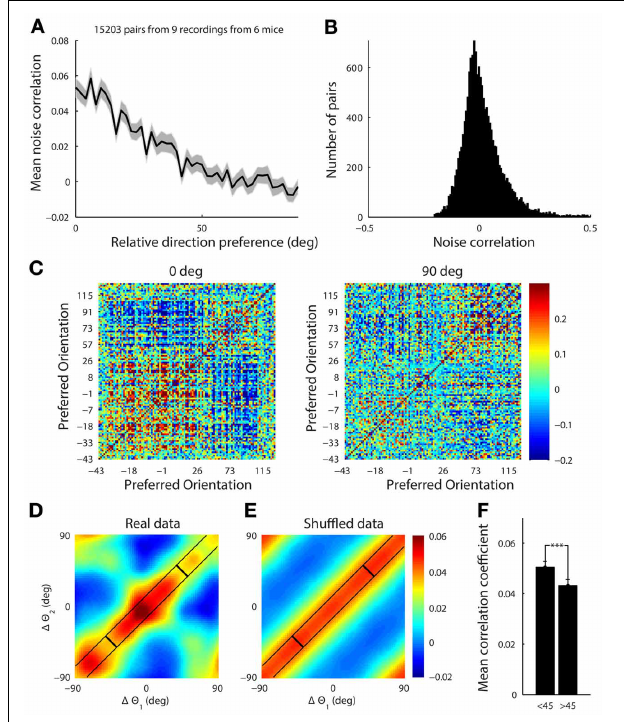
FIGURE 9 | (A) The mean noise correlation between pairs of tuned neurons vs. their difference in orientation, with error bar representing the standard error of the mean. This shows a limited range structure (B) Histogram of the noise correlation value for all pairs of neurons. (C) The correlation structure from a single site with a simultaneously recorded population of 108 tuned neurons in response to presentation of horizontal (0 ◦ ) and vertical (90 ◦ ) gratings drifting upwards and rightwards, respectively. The neurons are ordered by their preferred orientation, which are indicated on the axes. The white line indicates the presented stimulus. It is clear that there is a higher correlation amongst neurons when the stimulus is near both of their preferred orientations. (D) This effect was characterized by collapsing across 9 datasets. For each stimulus the noise correlation, r , was measured for a pair of cells, and the difference between the stimulus ( s ,either horizontal or vertical) and the preferred orientation ( θ ) for each cell ( (cid:4) θ = s − θ ) was computed. The set of points from all the pairs of cells under both stimuli, ( (cid:4) θ 1 , (cid:4) θ 2 , r ) , were then smoothed using a Gaussian kernel (Hastie et al., 2009) with a standard deviation of 10 ◦ . There is structure in both diagonal directions reflecting both limited range correlations and stimulus dependent changes in the correlation structure. (E) The presented stimulus orientation was shuffled to demonstrate what a purely limited range correlation structure with no stimulus dependence would look like. (F) Average noise correlation from all datasets for pairs of neurons with similar preferred orientation (within 10 ◦ ) when the stimulus was near their mean preferred orientation ( < 45 ◦ column) vs. further away ( > 45 ◦ ). ∗∗∗ p <